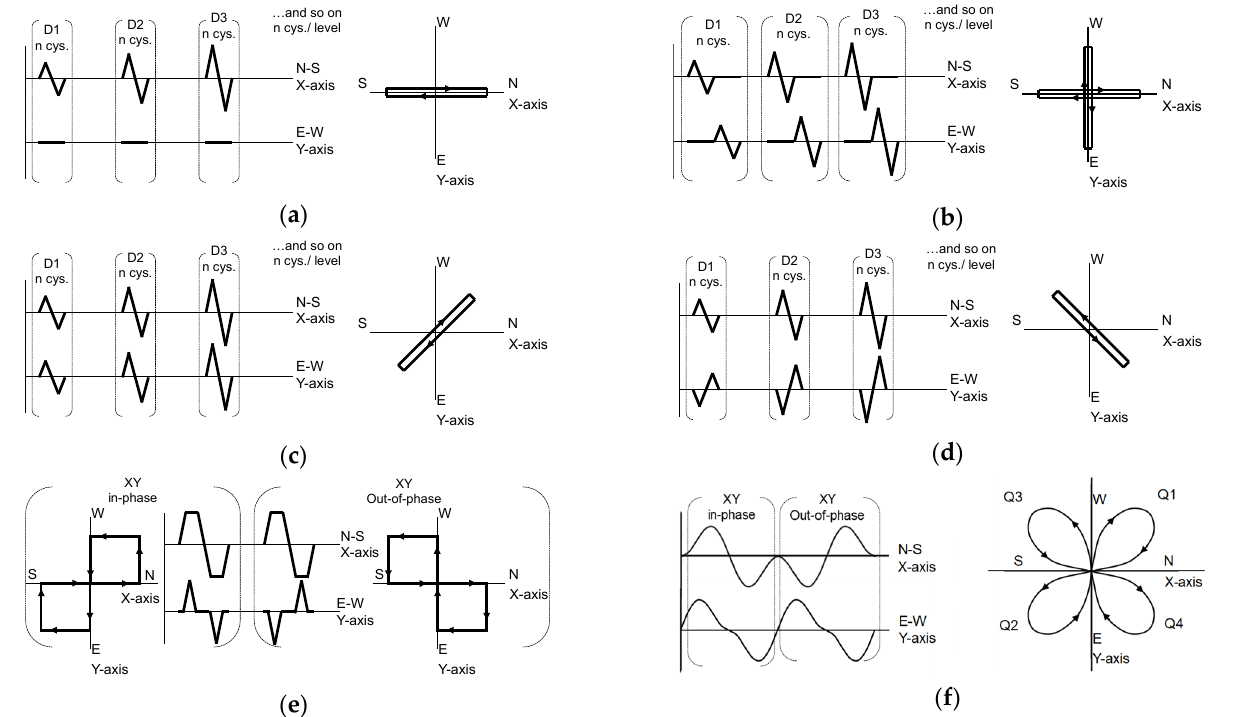
Figure 4. Possible protocols (schematic) for bidirectional loading of BCJs: ( a ) unidirectional loading, ( b ) bidirectional alternating, ( c ) bidirectional simultaneous (XY in-phase), ( d ) bidirectional simultaneous (XY out of-phase) ( e ) bidirectional shape-of-8 ( f ) bidirectional cloverleaf shaped.